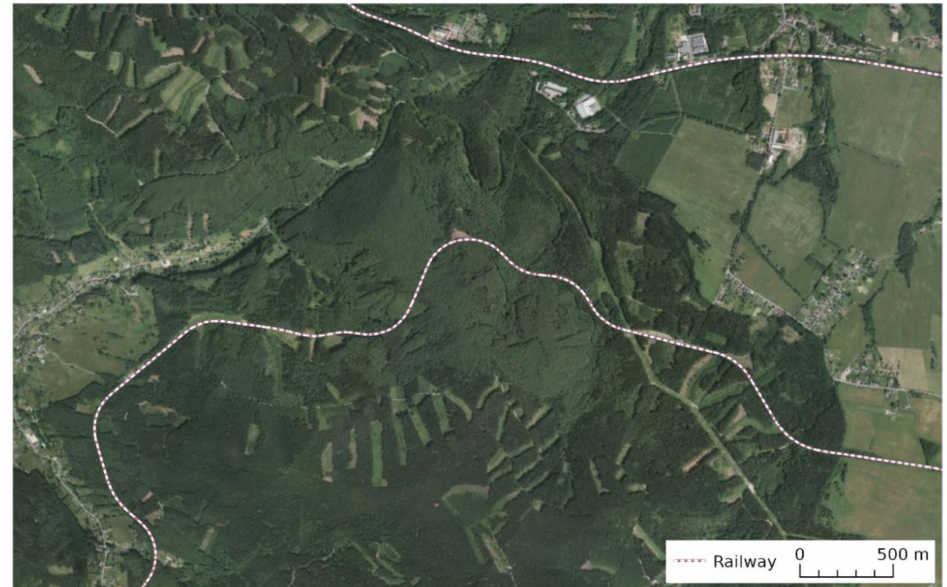
Figure 5. Example of railway line vector data in a true-color satellite